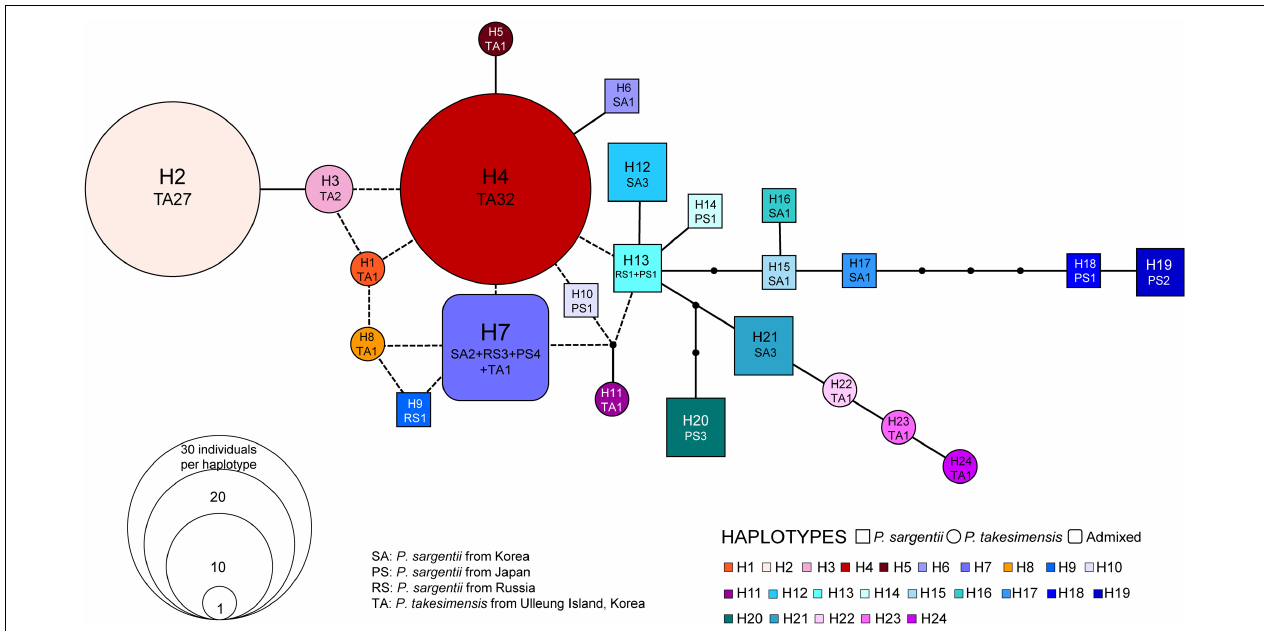
FIGURE 5 | TCS haplotype network constructed from five non-coding regions of cpDNA. Relationships among the 24 haplotypes found in P. takesimensis on Ulleung Island (circles) and its continental progenitor, P. sargentii , from adjacent areas (squares). Small dots represent either missing or inferred haplotypes and the size of each circle and square is proportional to the population size. TABLE 3 | Summary of the analysis of molecular variance (AMOVA) found between P. takesimensis and P. sargentii based on five non-coding regions of cpDNA. Species Source of variation d.f. Sum of